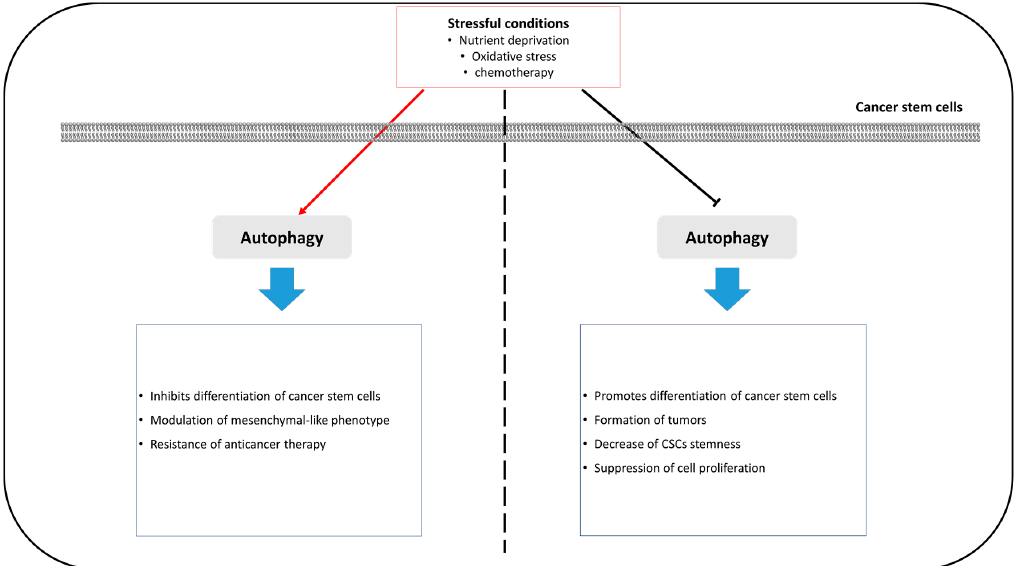
Figure 3. A schematic diagram of the autophagy roles in cancer stem-cells.